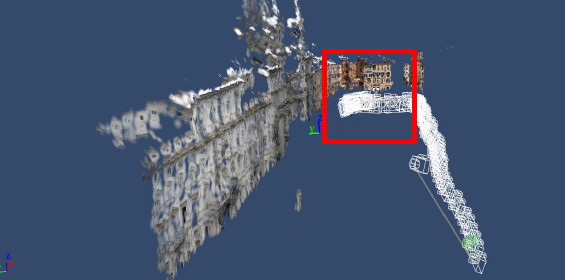
Figure 2. Navona Square, Rome, Automatic Reconstruction